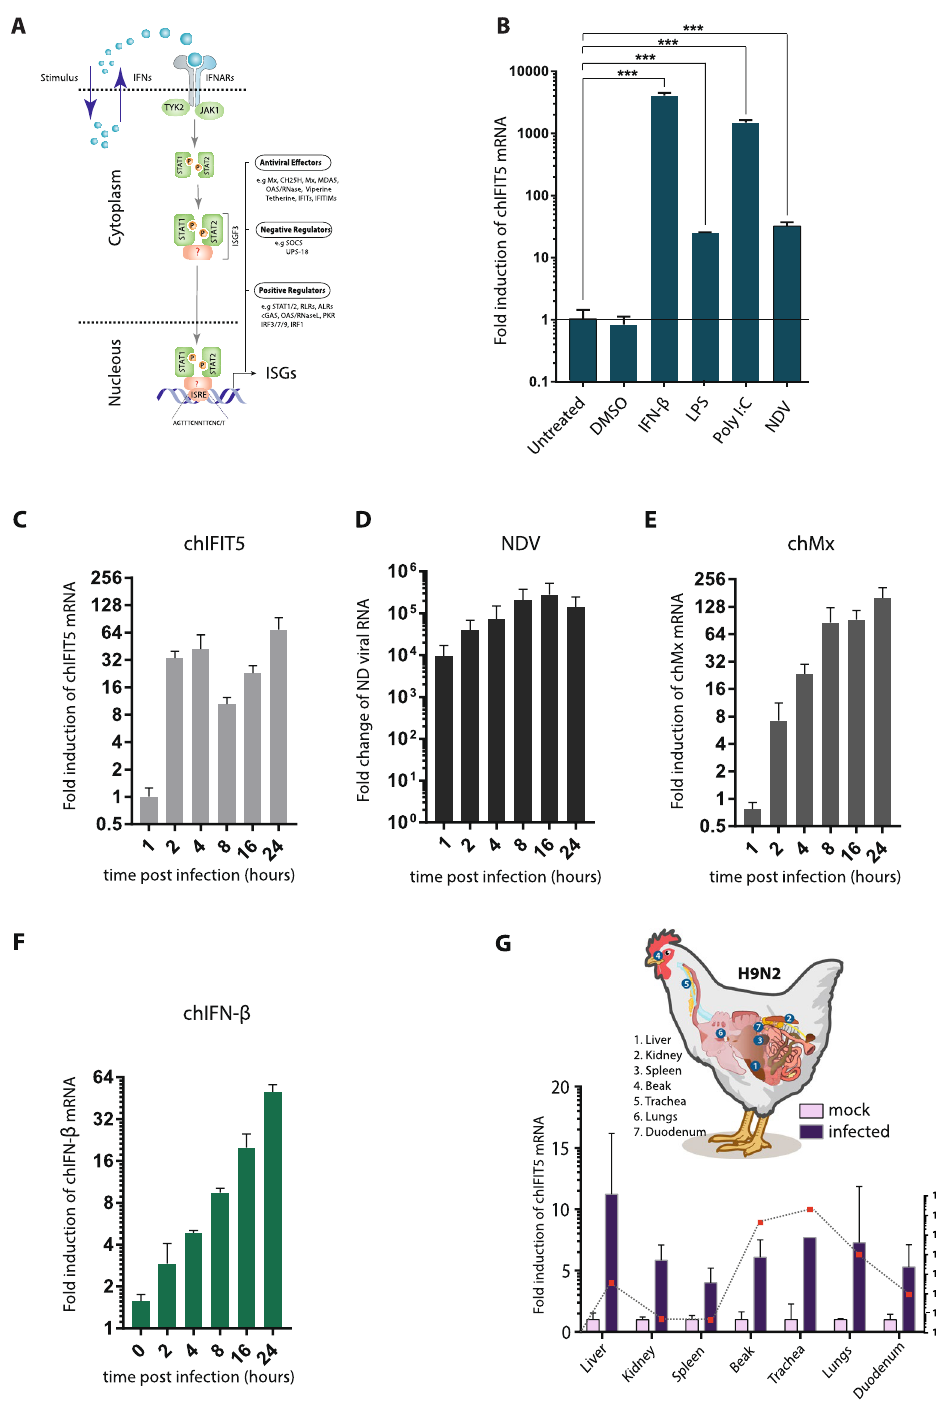
Figure 2. In vitro and ex vivo transcriptional regulation of chIFIT5 gene. ( A ) ChIFN- β itself, or produced by different stimuli, can initiate JAK-STAT signalling pathway and culminate in the induction of hundreds of ISGs. IFIT family of genes is one such antiviral effector of innate immune responses. ( B ) Quantitation of chIFIT5 mRNA in cells stimulated with 1000 U of chIFN- β , 10 μ g/mL of LPS, 5 μ g/mL of poly I:C or 1 MOI of NDV for 24 hours before RNA extraction and analysis for qRT-PCR using primers specific for the chIFIT5 gene. ( C–F ) Total cellular RNA was extracted from CEF cells at 1, 2, 4, 8, 16, and 24 hours post-NDV infection and was subjected to quantitation of mRNA for chIFIT5 ( C ), viral mRNA ( D ), chMx ( E ) and chIFN- β ( F , G ) RNA collected from seven organs infected or not with H9N2 influenza viruses were used to determine the level of chIFIT5 mRNA and M gene of the virus. Fold change induction in all experiments was determined by 2 − ∆∆ CT algorithm and data presented is average of three independent